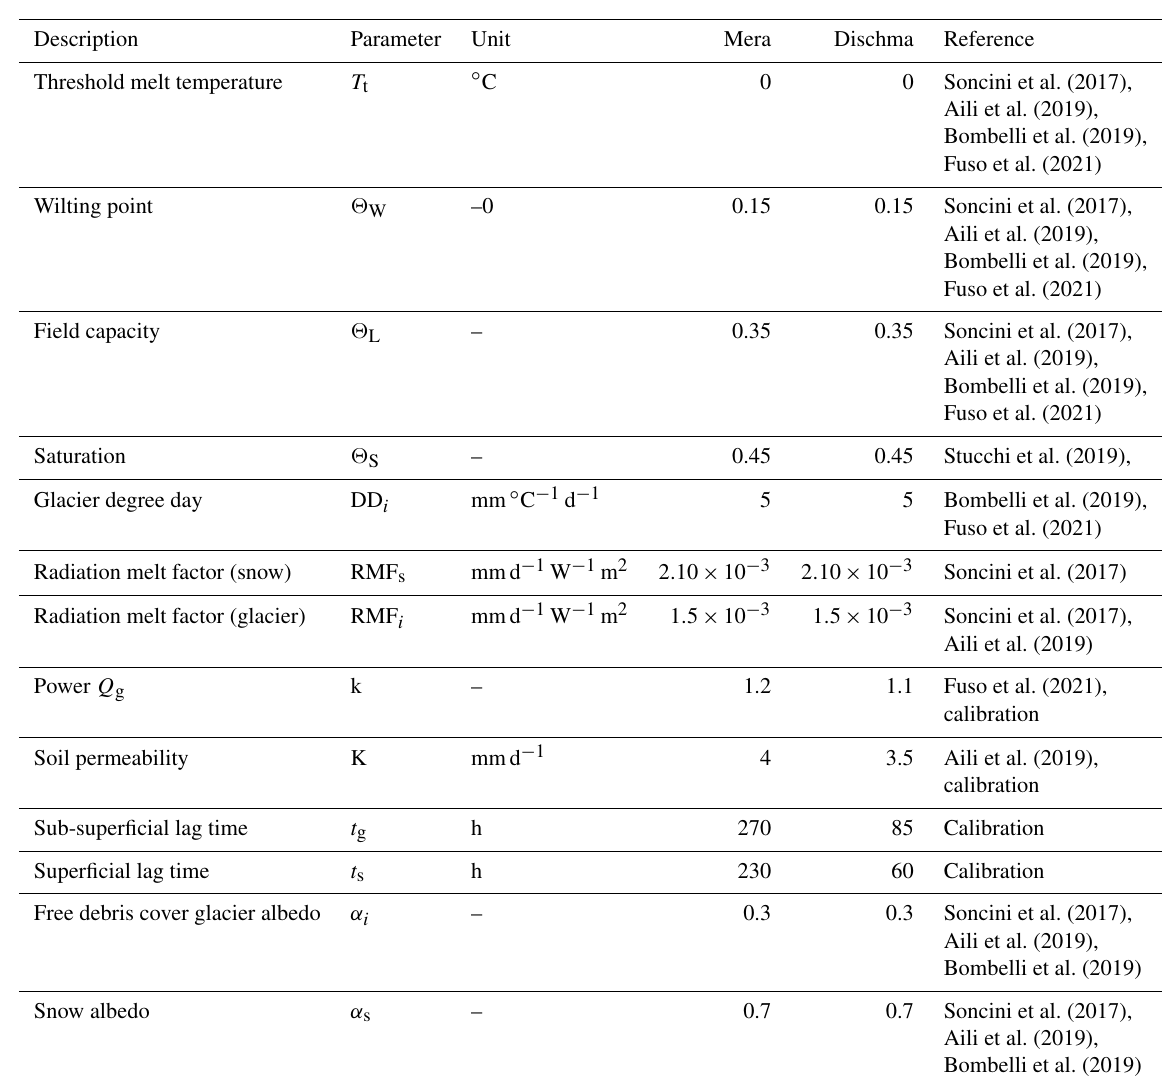
Table 8. Calibration parameters for the Poli-Hydro model.